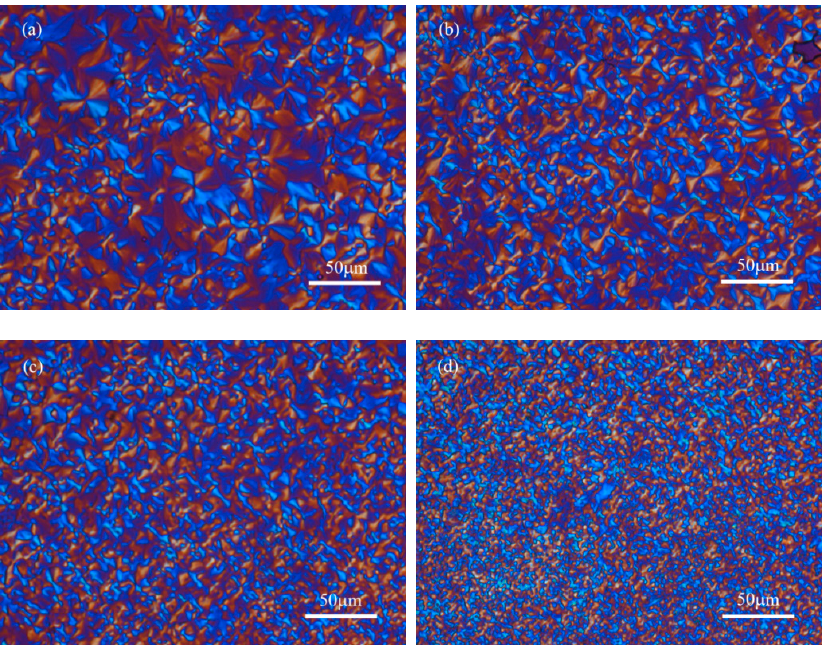
Figure 7. POM images of ( a ) PHS, ( b ) PHS/CNC0.25, ( c ) PHS/CNC0.5, and ( d ) PHS/CNC1 at 45 °C. Figure 8 depicts the WAXD profiles of PHS and PHS/CNC composites after they finished crystallization at 45 °C for 5 h. Three relatively strong diffraction peaks at 2 θ of 21.5°, 24.4° , and 30.3°, corresponding to the (220), (040), and (240) planes of PHS, respectively, were observed for PHS and PHS/CNC composites [13]. For both PHS and its composites, they displayed the similar WAXD profiles, suggesting that CNC did not modify the crystal structure of PHS. In addition, from Figure 8, the crystallinity values were estimated to be about 55% for PHS, PHS/CNC0.5, and PHS/CNC1, respectively. In the case of PHS/CNC0.25, the crystallinity was slightly increased to about 60%. In sum, CNC did not obviously affect the crystallinity of PHS, especially at CNC content of 0.5 wt% and above.